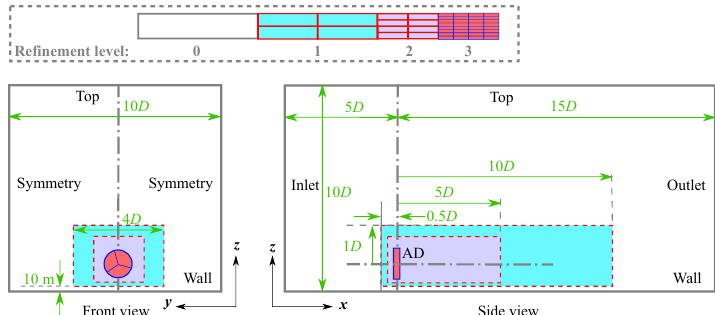
Figure 10. Compuational domain and meshing